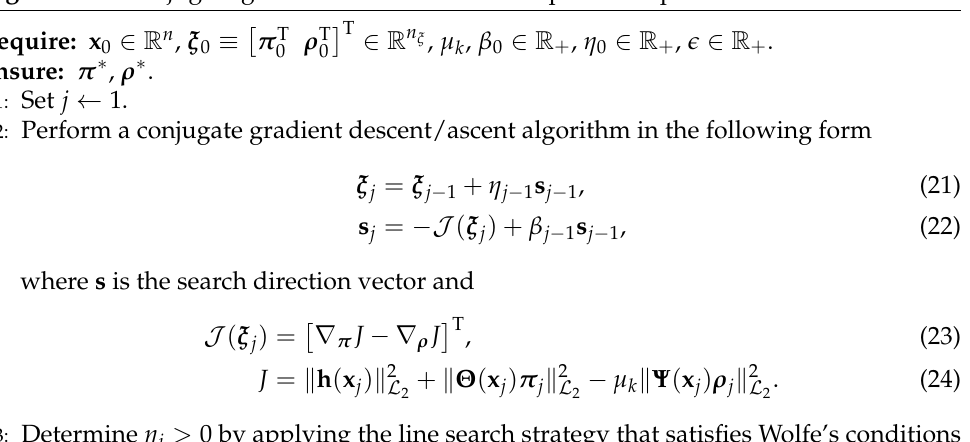
Algorithm 2 Conjugate gradient method for saddle point computation.